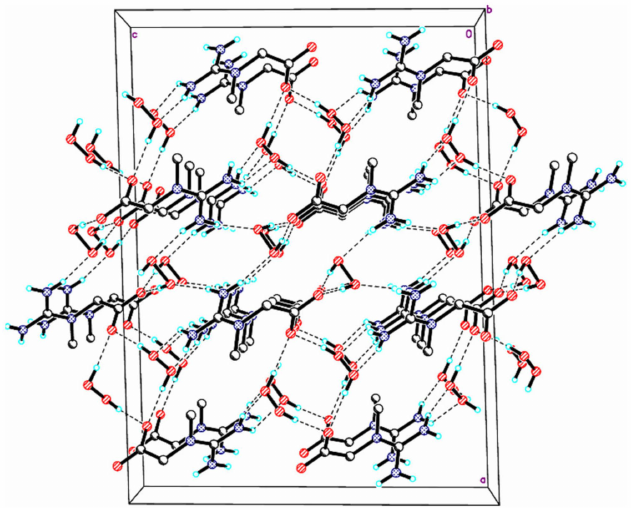
Figure 9. Three-dimensional packing motif in IV . Hydrogen bonds are shown by dashed